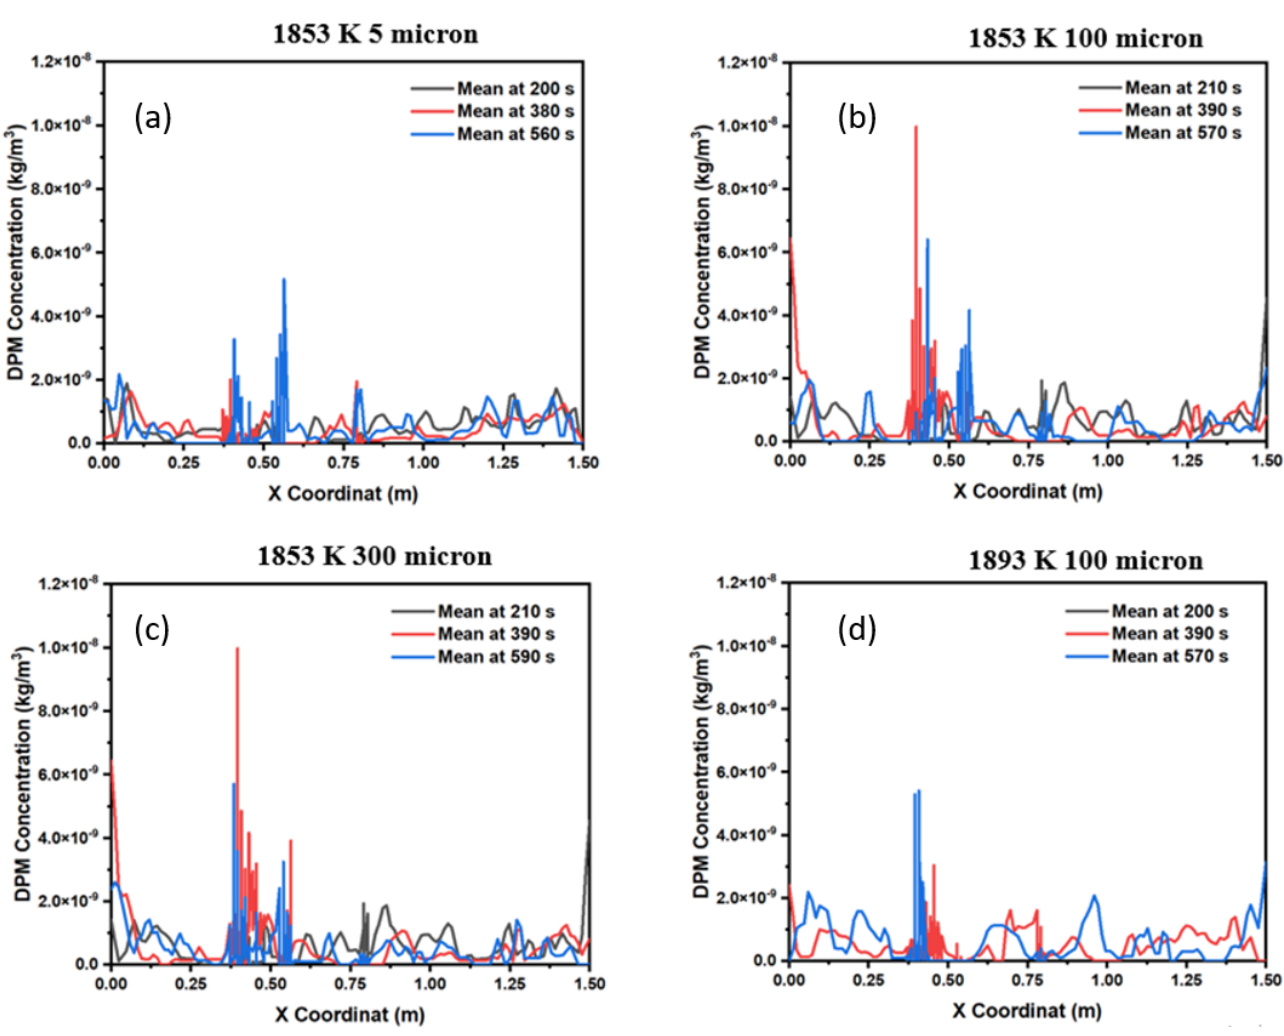
Figure 8. Inclusion concentration profile in the mold: ( a ) 5 microns, ( b ) 100 microns, ( c ) 300 microns, and ( d ) 100 microns (at 1893 K). and ( d ) 100 microns (at 1893